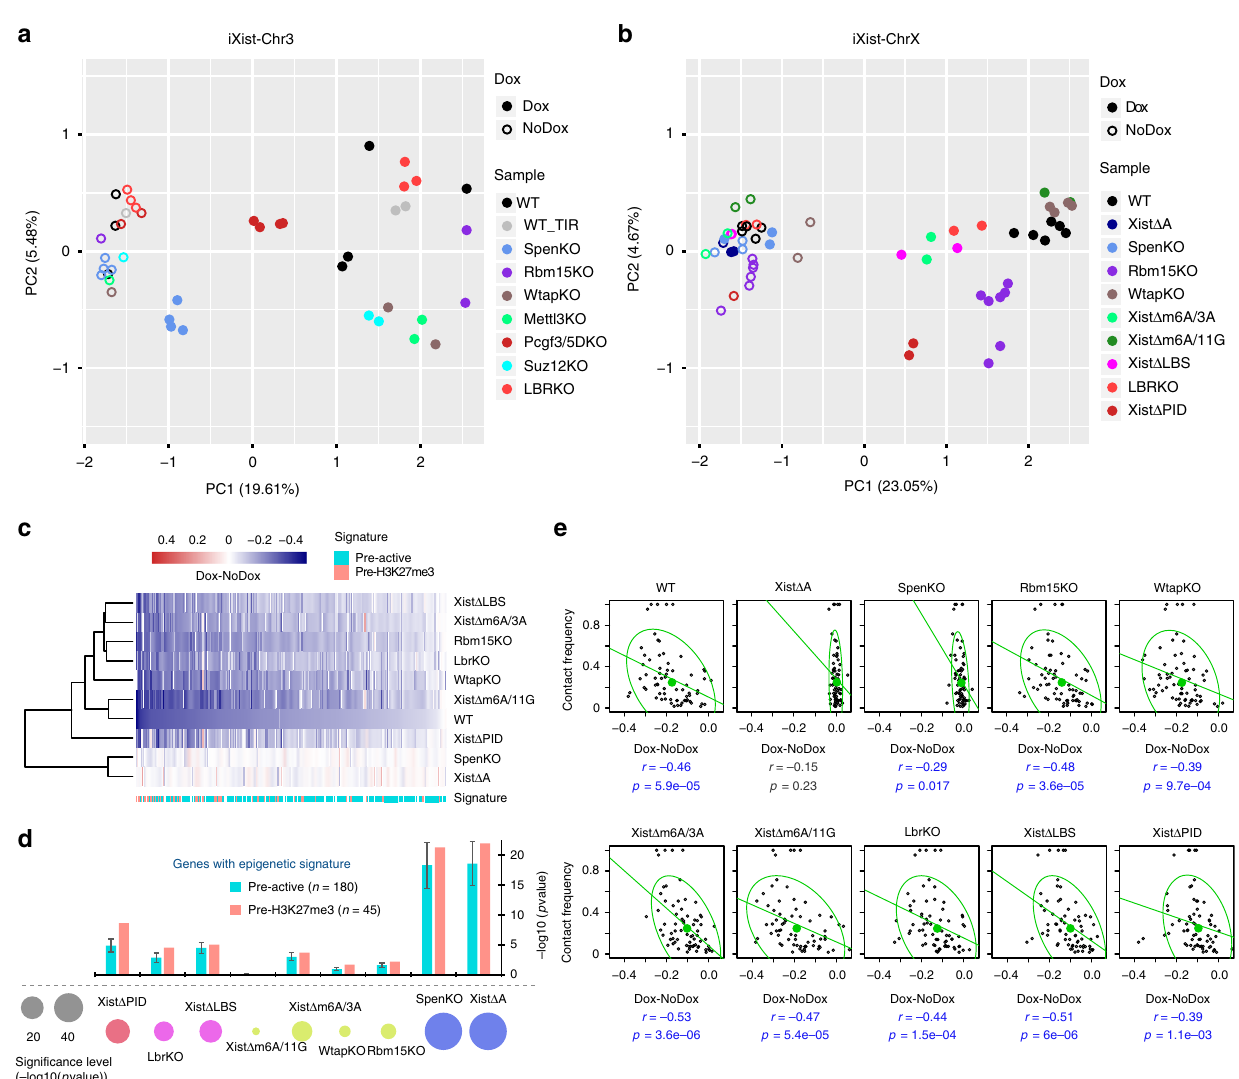
Fig. 7 Integrated analysis of key pathways in Xist-mediated silencing. a , b PCA analysis of biological replicates of ChrRNA-seq analysis for all uninduced and Xist-induced experiments in iXist-Chr3 ( a ) and iXist-ChrX ( b ) for WT and mutants. c Cluster analysis and heatmap for silencing ef fi ciency of ChrX genes in selected mutant mESCs, as indicated after 1 day of Xist RNA induction. Gene order is ranked by silencing ef fi ciency in WT iXist-ChrX cells. Chromatin signature de fi ned by ChromHMM is shown below. d Silencing levels in different mutants in iXist-ChrX cells illustrated as one-sided Wilcoxon rank-sum signi fi cance. Bar charts illustrate separate signi fi cance scores for genes classi fi ed according to pre-existing active (pre-active) and H3K27me3 (pre-H3K27me3) chromatin signatures, corrected for sample size. Error bars indicate signi fi cance range for 180 permutations. e Correlation analysis for topological distance and silencing ef fi ciency for WT and selected mutant mESCs in iXist-ChrX model. Ninety- fi ve per cent of the population is encircled. Spearman correlation and p values are indicated